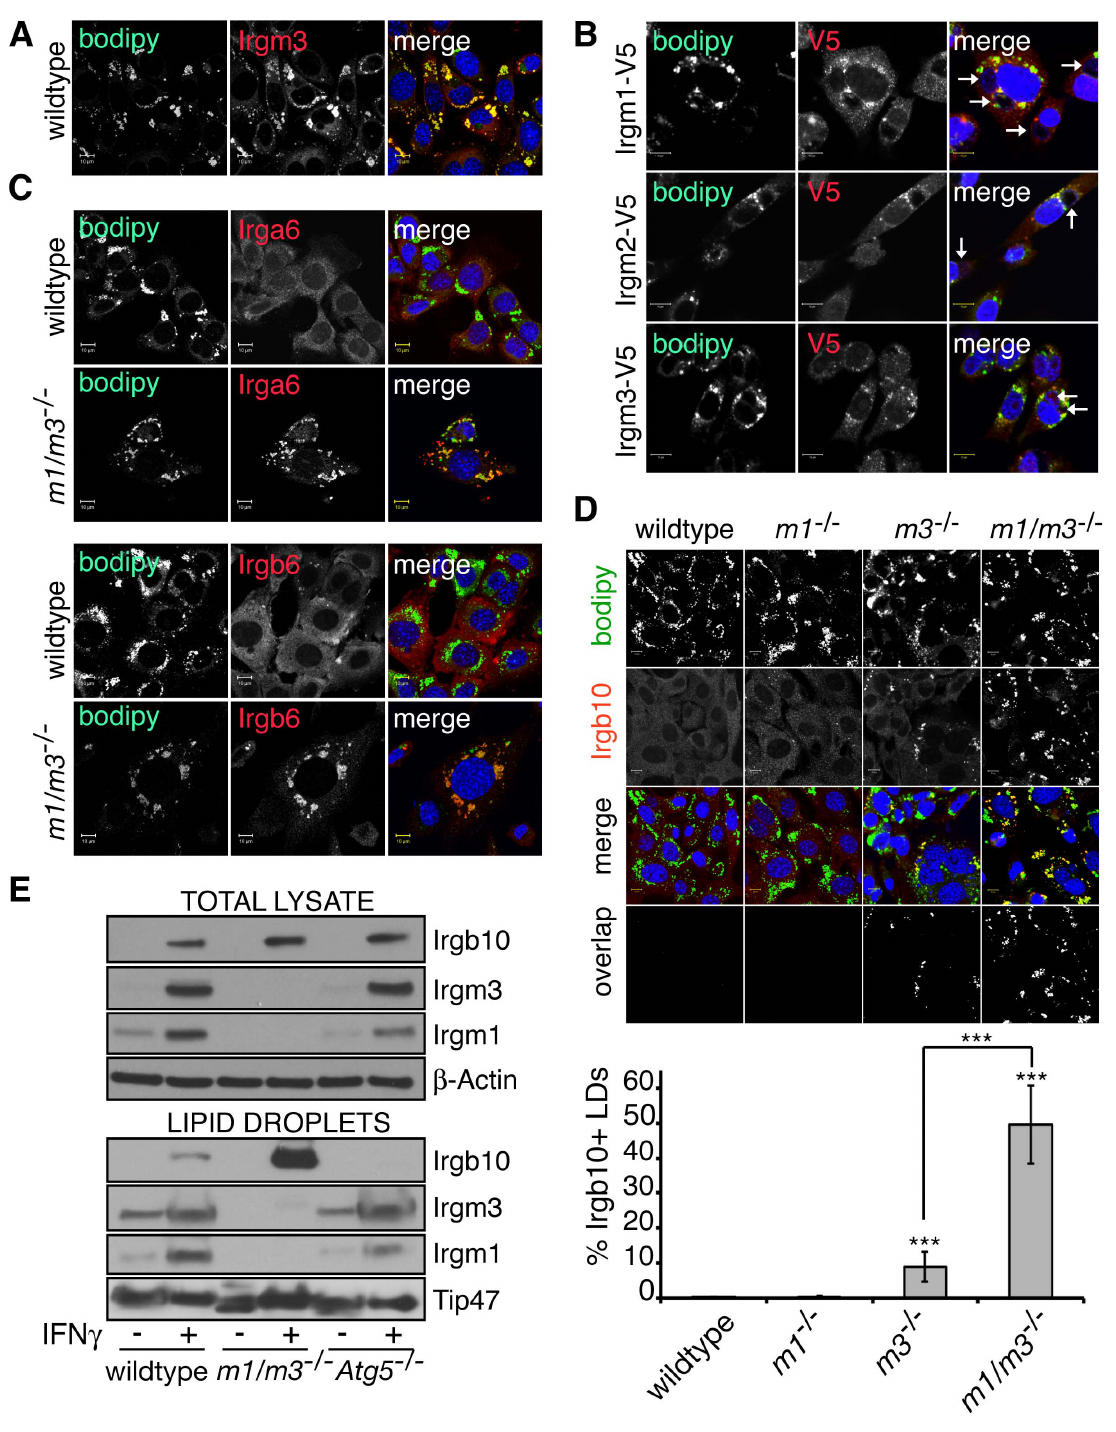
Figure 5. GKS proteins are enriched on LDs in IRGM-deficient cells. ( A ) Wildtype MEFs were treated overnight with OA and IFN c and immunostained for endogenous Irgm3 and for LDs using BODIPY. ( B ) Wildtype MEFs were transfected with the three mouse paralogs Irgm1-3 tagged with V5, infected with C. trachomatis and treated with OA and IFN c at 3 hpi. Cells were fixed at 20 hpi and stained with anti-V5, BODIPY and Hoechst. White arrows point at inclusions. ( C ) The localization of the GKS proteins Irga6 and Irgb6 were visualized in wildtype and Irgm1/m3 2 / 2 MEFs treated overnight with OA and IFN c . ( D ) Cells were treated overnight with OA and IFN c and stained with anti-Irgb10, BODIPY and Hoechst. Representative images are shown. Overlap in fluorescence signals derived from anti-Irgb10 and BODIPY stains is shown for these representative images. Data were analyzed as described in Materials and Methods and representative data of three independent experiments are shown. Statistical significance of group values relative to wildtype and between marked groups is shown (***, p , 0.005). ( E ) LDs and total cell lysate were obtained from wildtype, Irgm1/m3 2 / 2 and Atg5 2 / 2 MEFs treated overnight with OA + / 2 IFN c and analyzed by immunoblotting.